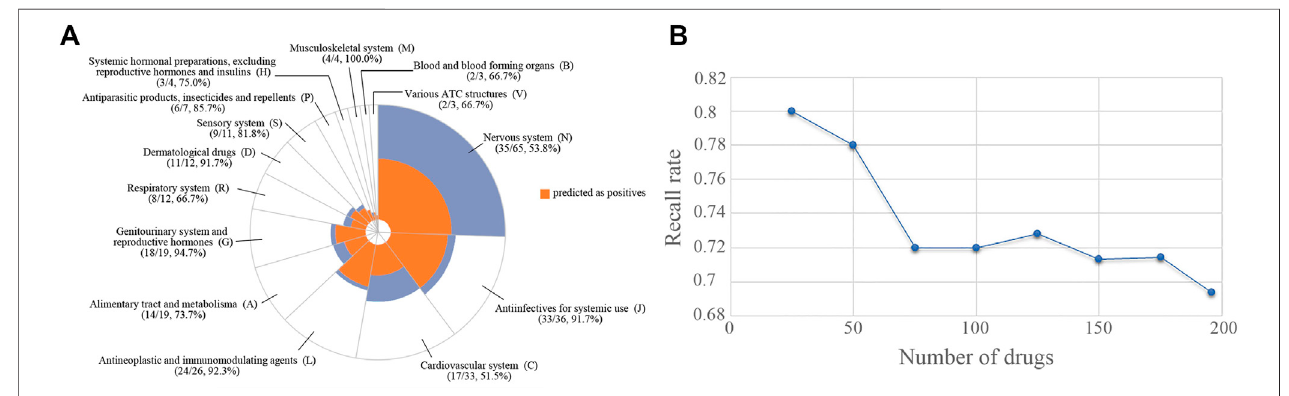
FIGURE 3 | The distribution of the drugs with teratogenic risk in different therapeutic categories in FAERS and the recall rates obtained by SVM model. (A) Distribution of all the drugs and the drugs predicted as positives. (B) The trend of recall rate changed with the number of drugs increased.